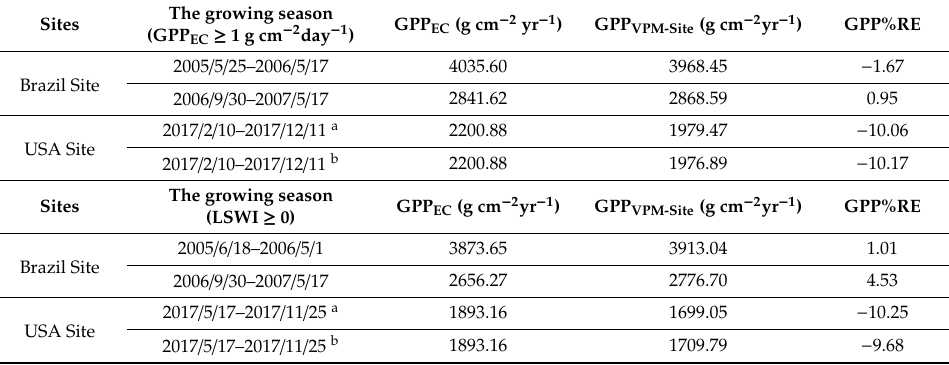
Table 1. A summary of the estimated gross primary production (GPP EC ) and predicted GPP VPM-Site at the sugarcane EC tower sites in Brazil and USA during the growing season defined by GPP EC and LSWI, respectively. GPP EC represents the seasonal sum of the estimated GPP from the sugarcane EC flux tower sites; GPP VPM-Site represents the seasonal sum of the predicted GPP from the VPM model; a and b are the seasonal sum the GPP VPM-Site at the USA site when T opt = 25 ◦ C and T opt = 28 ◦ C, respectively.